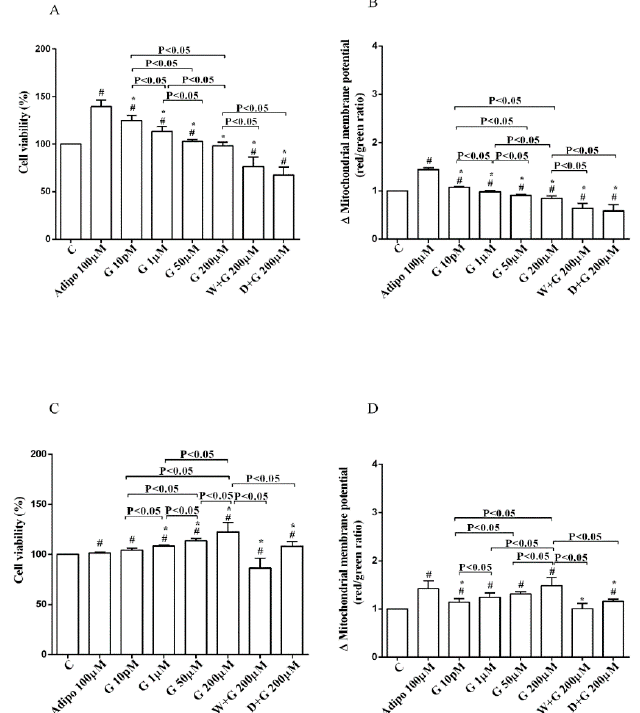
Figure 3. Effects of genistein in white adipocytes, cultured in physiological condition, on cell viability ( A ) and mitochondrial membrane potential ( B ), and in brown adipocytes, on cell viability ( C ) and mitochondrial membrane potential ( D ). Abbreviations are as in Figures 1 and 2. Reported data are means ± SD of five independent experiments for each experimental protocol executed in adipocytes taken from each patient. Significance between groups: # p < 0.05 vs. control; * p < 0.05 vs. Adipo 100 µM. Short square brackets indicate significance between groups ( p < 0.05).